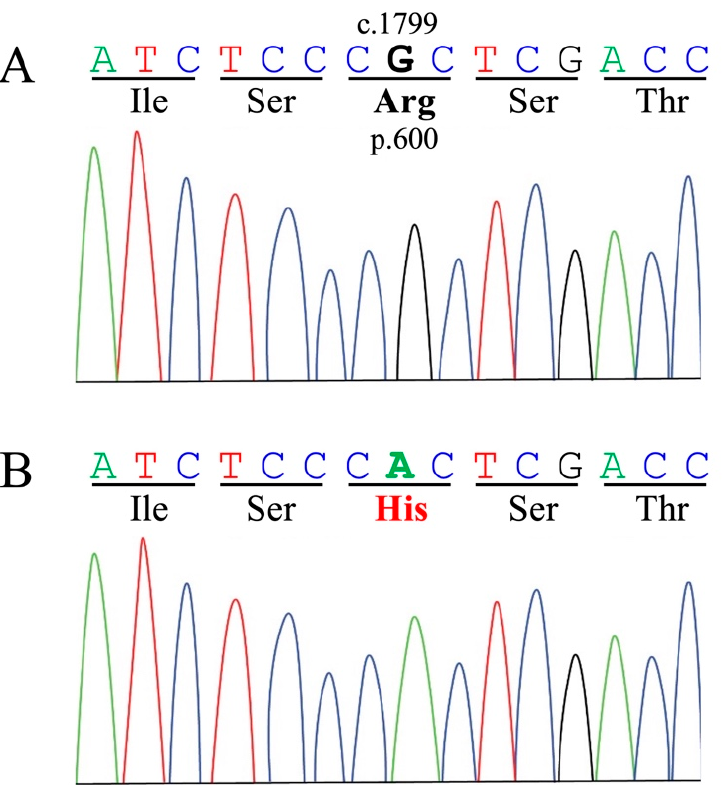
Figure 2. Comparison of sequenced data of the a ff ected cat with the reference data in exon 13 of the feline GAA gene (c.1799G>A, p.R600H). The Sanger sequencing for a wild-type homozygous geno- type ( A ) and a mutant homozygous genotype (( B ), the a ff ected cat) are shown.